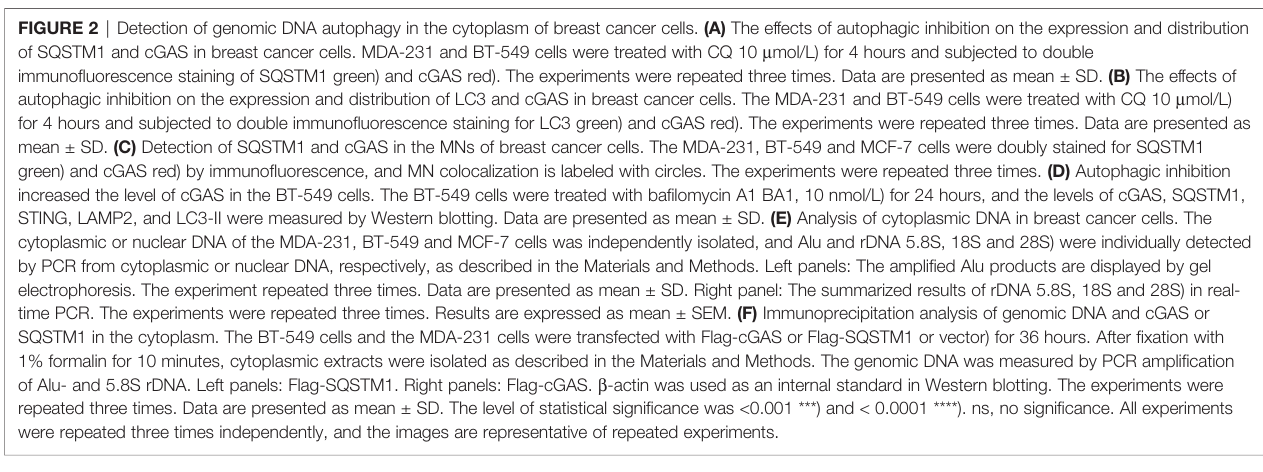
FIGURE 2 | Detection of genomic DNA autophagy in the cytoplasm of breast cancer cells. (A) The effects of autophagic inhibition on the expression and distribution of SQSTM1 and cGAS in breast cancer cells. MDA-231 and BT-549 cells were treated with CQ 10 m mol/L) for 4 hours and subjected to double immuno fl uorescence staining of SQSTM1 green) and cGAS red). The experiments were repeated three times. Data are presented as mean ± SD. (B) The effects of autophagic inhibition on the expression and distribution of LC3 and cGAS in breast cancer cells. The MDA-231 and BT-549 cells were treated with CQ 10 m mol/L) for 4 hours and subjected to double immuno fl uorescence staining for LC3 green) and cGAS red). The experiments were repeated three times. Data are presented as mean ± SD. (C) Detection of SQSTM1 and cGAS in the MNs of breast cancer cells. The MDA-231, BT-549 and MCF-7 cells were doubly stained for SQSTM1 green) and cGAS red) by immuno fl uorescence, and MN colocalization is labeled with circles. The experiments were repeated three times. (D) Autophagic inhibition increased the level of cGAS in the BT-549 cells. The BT-549 cells were treated with ba fi lomycin A1 BA1, 10 nmol/L) for 24 hours, and the levels of cGAS, SQSTM1, STING, LAMP2, and LC3-II were measured by Western blotting. Data are presented as mean ± SD. (E) Analysis of cytoplasmic DNA in breast cancer cells. The cytoplasmic or nuclear DNA of the MDA-231, BT-549 and MCF-7 cells was independently isolated, and Alu and rDNA 5.8S, 18S and 28S) were individually detected by PCR from cytoplasmic or nuclear DNA, respectively, as described in the Materials and Methods. Left panels: The ampli fi ed Alu products are displayed by gel electrophoresis. The experiment repeated three times. Data are presented as mean ± SD. Right panel: The summarized results of rDNA 5.8S, 18S and 28S) in real- time PCR. The experiments were repeated three times. Results are expressed as mean ± SEM. (F) Immunoprecipitation analysis of genomic DNA and cGAS or SQSTM1 in the cytoplasm. The BT-549 cells and the MDA-231 cells were transfected with Flag-cGAS or Flag-SQSTM1 or vector) for 36 hours. After fi xation with 1% formalin for 10 minutes, cytoplasmic extracts were isolated as described in the Materials and Methods. The genomic DNA was measured by PCR ampli fi cation of Alu- and 5.8S rDNA. Left panels: Flag-SQSTM1. Right panels: Flag-cGAS. b -actin was used as an internal standard in Western blotting. The experiments were repeated three times. Data are presented as mean ± SD. The level of statistical signi fi cance was <0.001 ***) and < 0.0001 ****). ns, no signi fi cance. All experiments were repeated three times independently, and the images are representative of